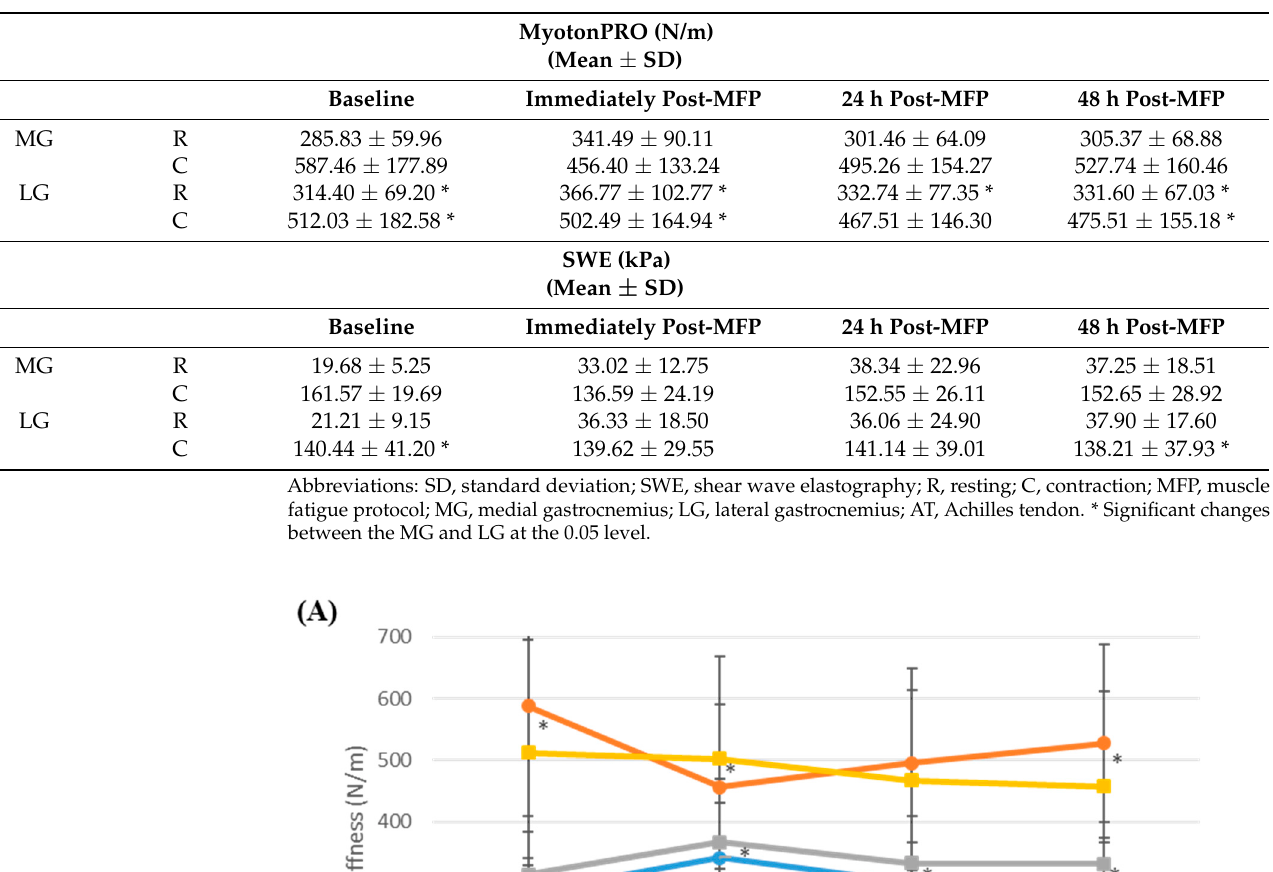
Table 3. Differences between muscles at rest and in contraction states across all measurement time points ( N = 35).